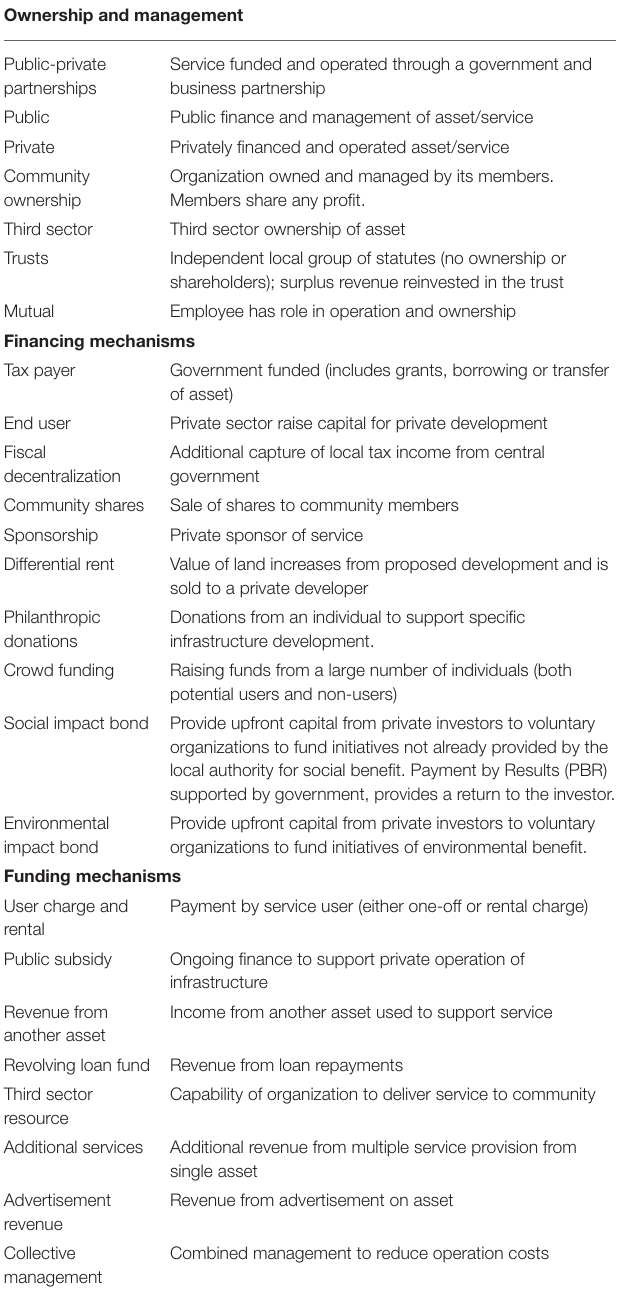
TABLE 1 | Summary of ownership and management of assets and funding and financing mechanisms for